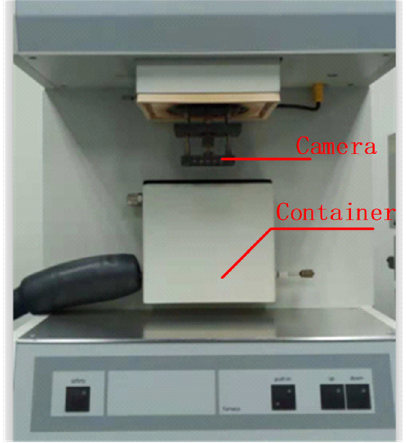
Figure 2. The equipment of creep experiment mainly consists of two parts, a high-resolution camera and a container. Camera can record the micro deformation of object in the container, and the container is a temperature ‐ controlled oven which can provide precise temperature from − 70 °C to +100 °C.